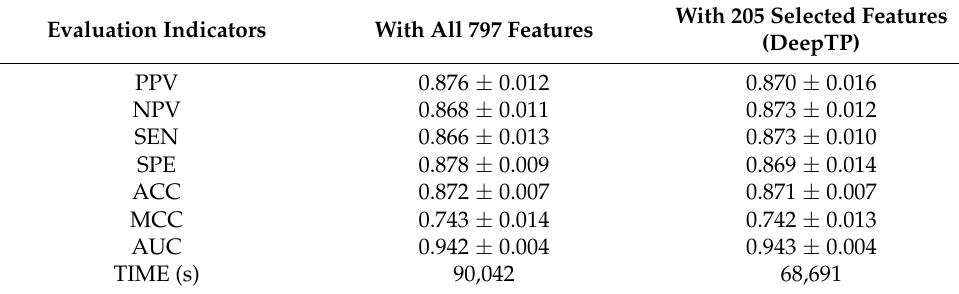
Table 1. 10-fold cross-validation performance in training set. Evaluation